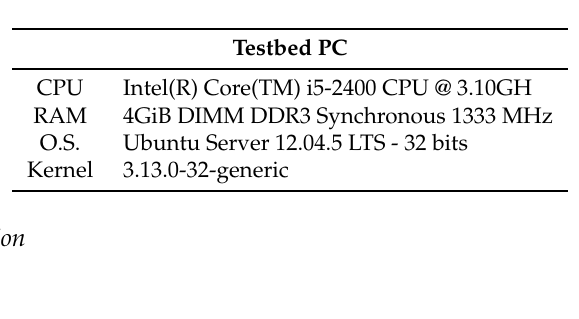
Table 1. Specifications of the computer used for the testbed.